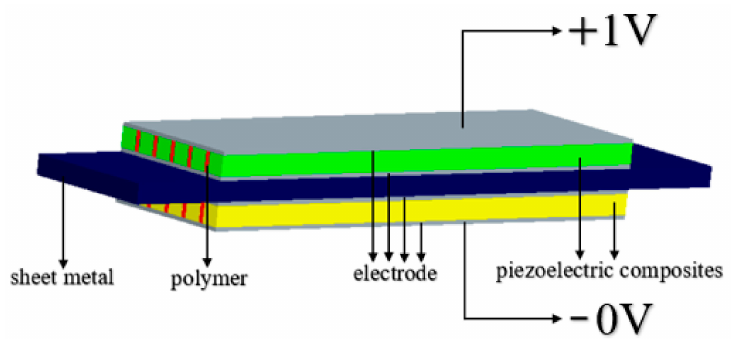
Figure 3. 2-2 piezoelectric composite trilaminar vibrator.